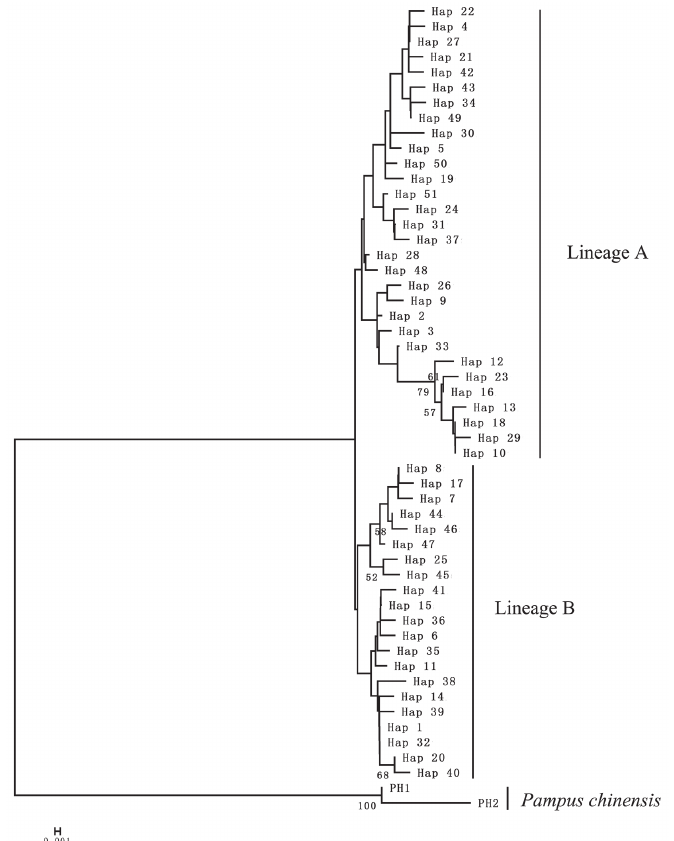
Figure 2. NJ tree of CR haplotypes of P. argenteus . Pampus chinensis was used as the out-group. Bootstrap supports >50 in 1,000 replicates are